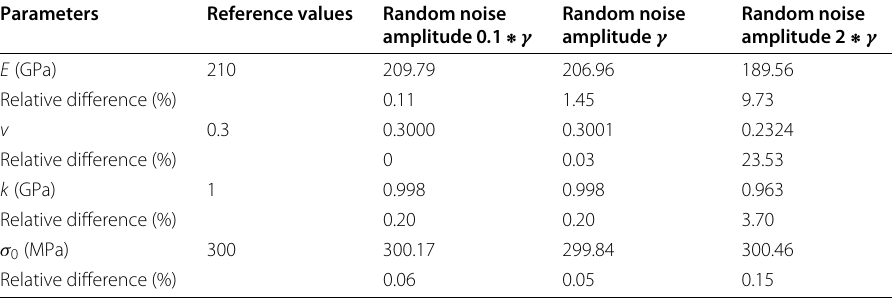
Table 3 Sensitivity to noise: specimen